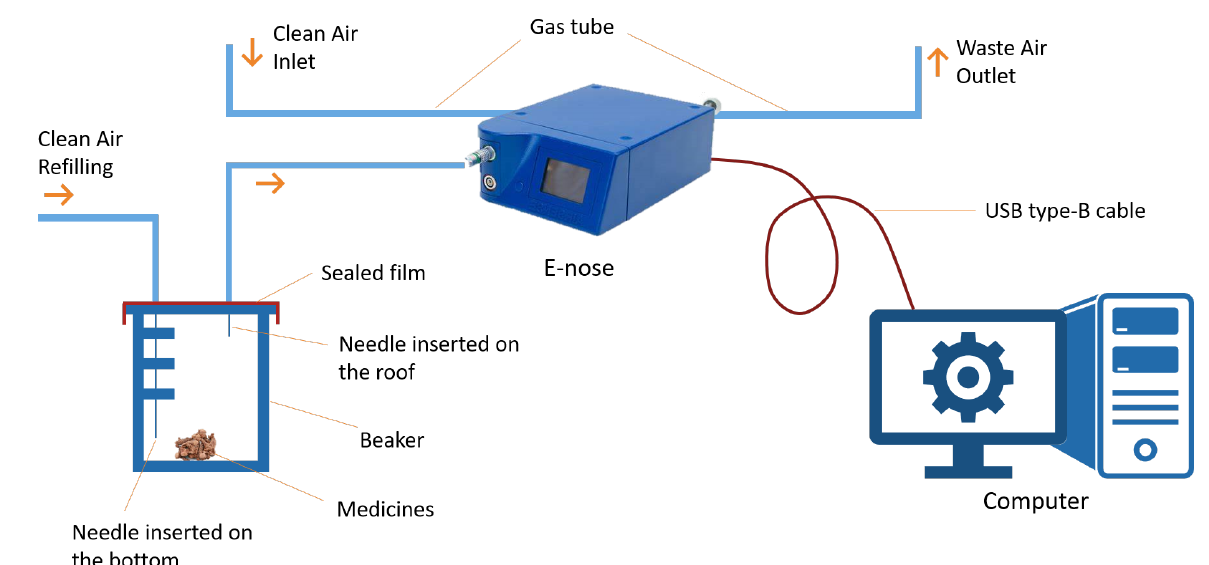
Figure 2. The architecture of the experimental setup for collecting odor response data. Chinese Herbal medicines were selected as the experimental materials, and they were placed in clean beakers covered by a sealed film. A needle was inserted into the bottom for clean-air refilling. Another needle was inserted on the roof of the beaker beneath the sealed film for collecting headspace gases. The clean-air inlet was connected to the purge gas port on the PEN-3 e-nose for flushing gas sensors, and the waste-air outlet was connected to the waste port for ejecting waste gases. Response data were collected by the e-nose and transmitted to a computer via a USB Type-B cable connecting e-nose and